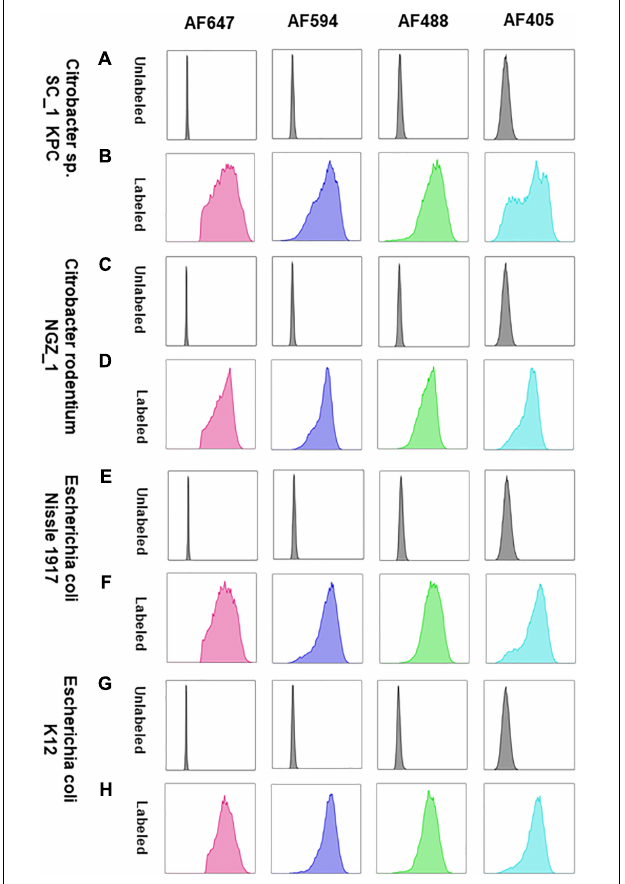
FIGURE 4 | COMBICK enables multi-fluorophore labeling of different Enterobacteriaceae species using flow cytometry. Labeling of different Enterobacteriaceae species with several fluorophores simultaneously (AF647, AF4594, AF488, and AF405). Each column represents a different fluorophore channel. (A,C,E,G) Flow cytometry histograms of the unlabeled Enterobacteriaceae species. (B,D,F,H) Flow cytometry histograms of the labeled Enterobacteriaceae species with 4 fluorophores